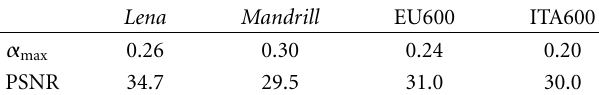
Table 2:Maximum watermark strength, α max ,subject to watermark invisibility and corresponding PSNR (dB) obtained for 4 test with the DWT-domain watermarking algorithm described in [8,9].